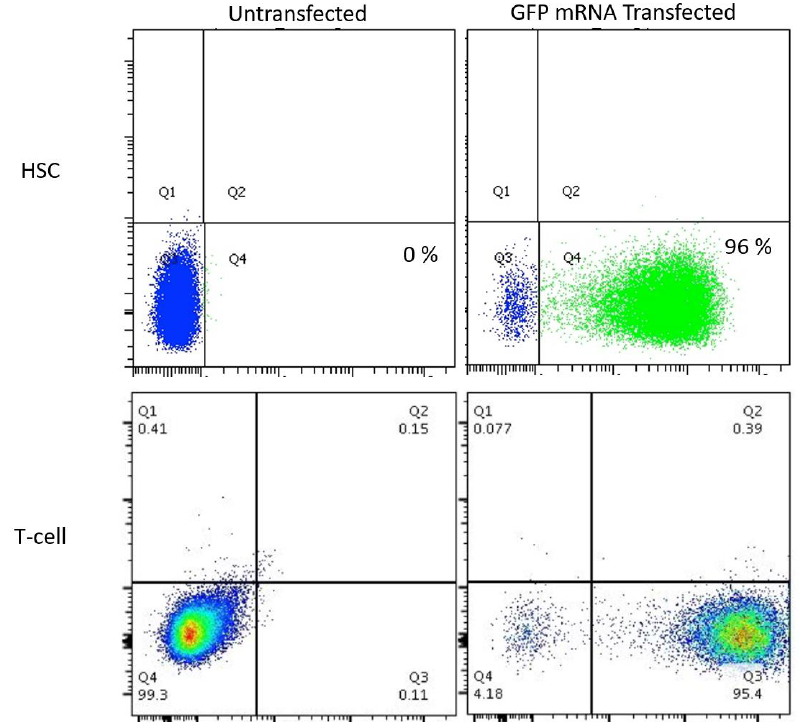
Figure A2. CD34 cells and T-cells were electroporated with one microgram of GFP mRNA under the optimal conditions and assessed for GFP expression at 48 h post gene transfer. Untransfected cells and a representative FACS plot of four electroporation experiments is shown.